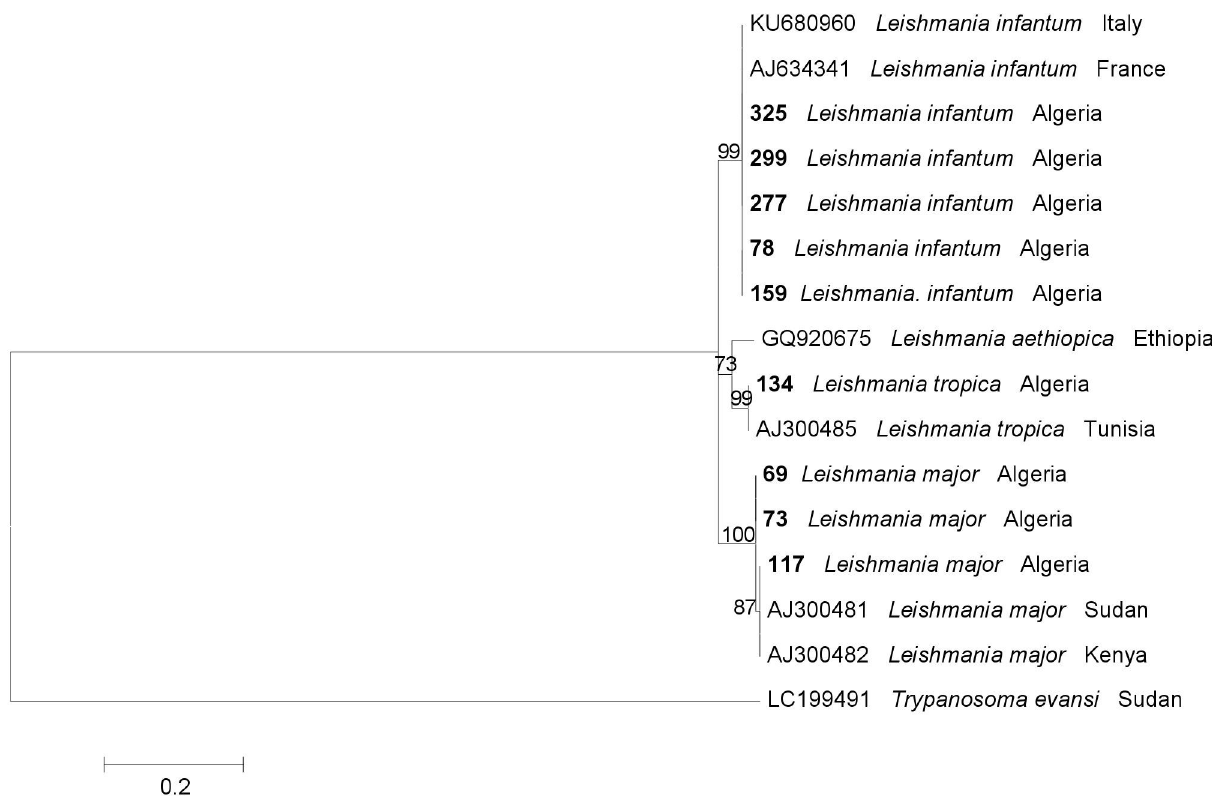
Fig 5. Maximum Likelihood tree based on ITS2 sequences of Leishmania spp. generated herein and sequences from GenBank (accession numbers provided). Bootstrap values are based on 8000 replicates and only bootstraps > 50% are indicated. Trypanosoma evansi was used as outgroup. Identification numbers of sand flies positive for Leishmania spp. are reported in bold.